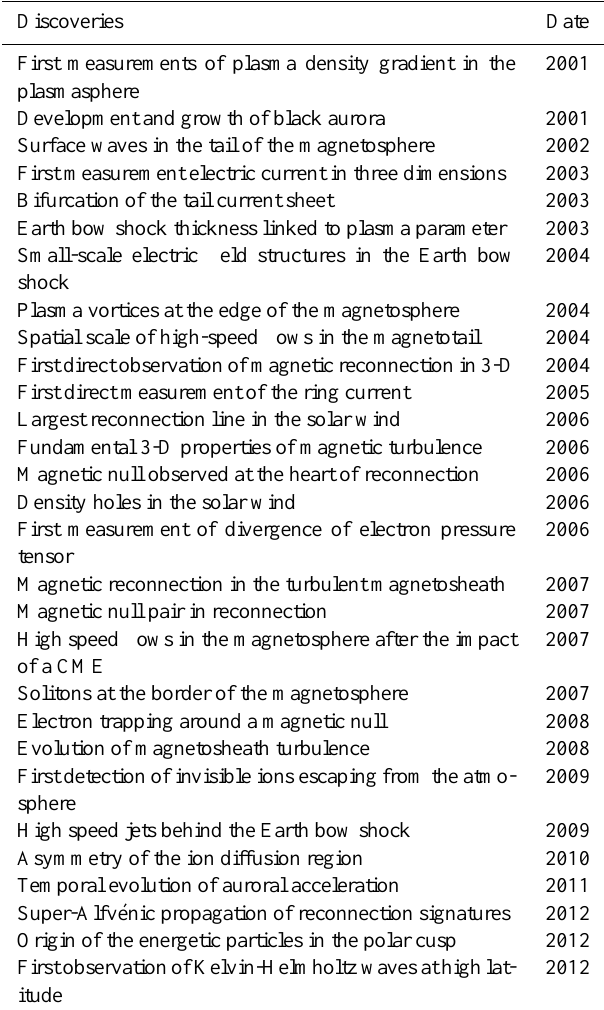
Table 1. Cluster selected discoveries (more details at http://sci.esa. int/cluster).